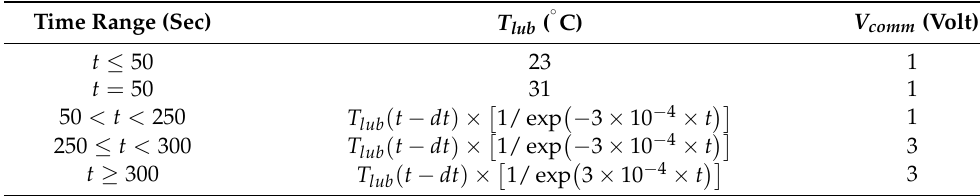
Table 3. Validation scenario for the first-state estimation block.